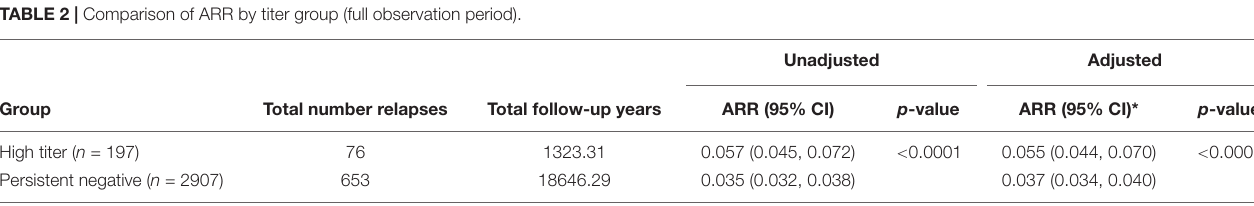
TABLE 2 | Comparison of ARR by titer group (full observation